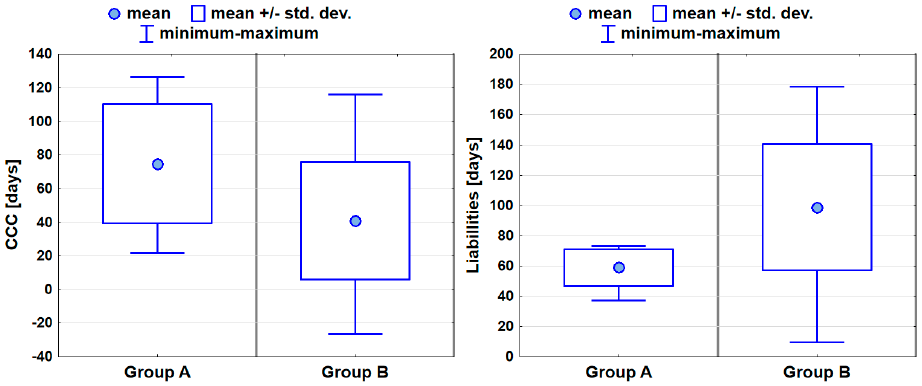
Figure 1. Comparison of CCC and liabilities in group A and B.